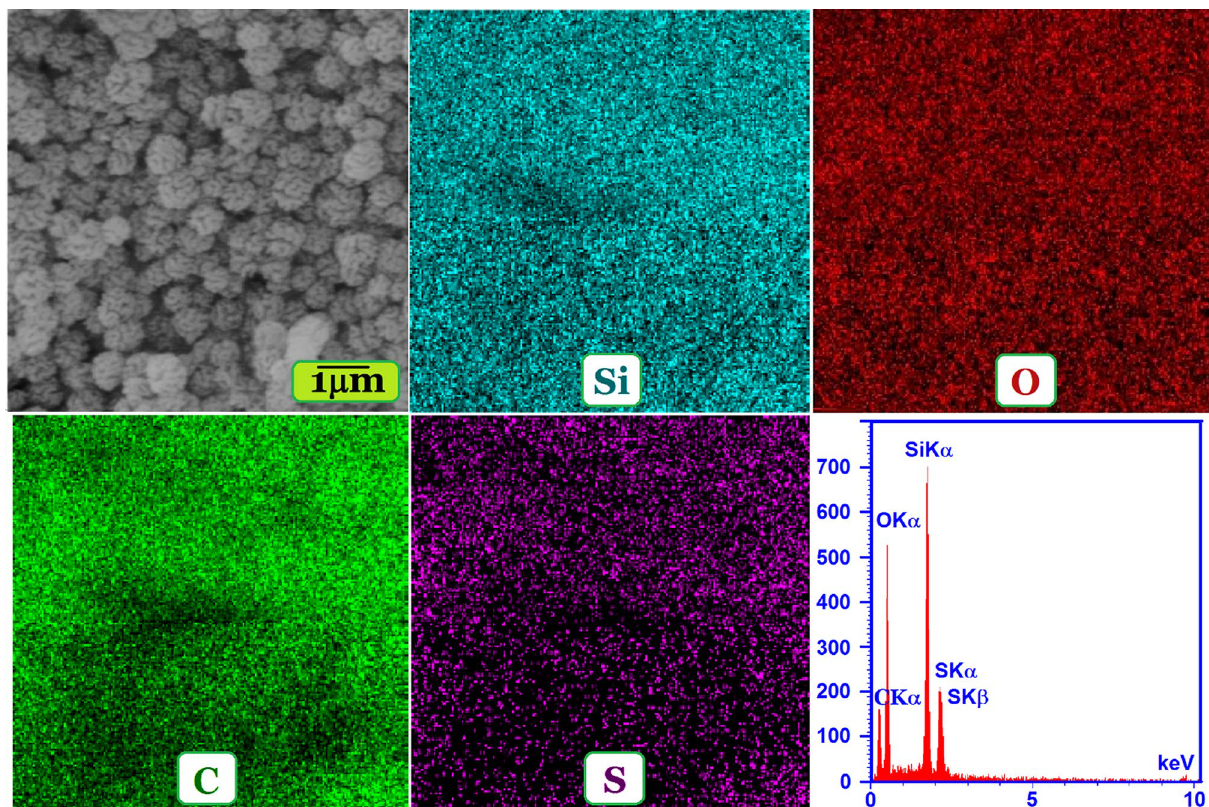
Figure 3. EDS and EDS elemental mapping of TSF-KCC-1 material.